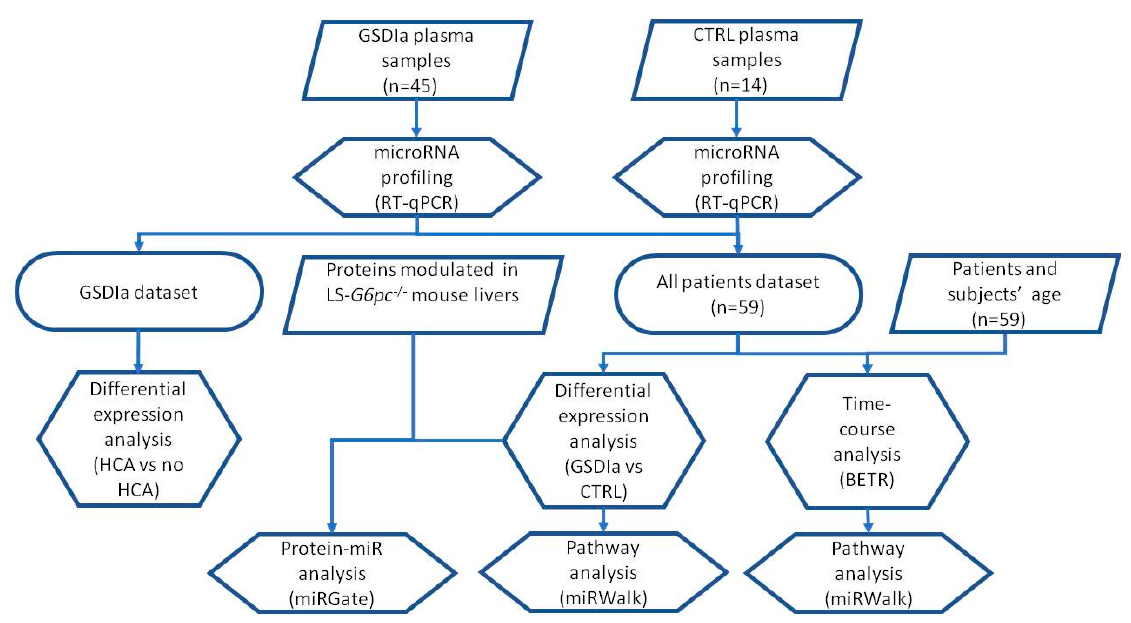
Figure 1. Schematic representation of the whole bioinformatic strategy used in the study. The Exo- miR representation profiles of plasma exosomes of 45 GSDIa patients and 14 CTRL subjects were measured via ViiA 7 RT-qPCR. Differential expression analysis assessed any significant modulation of the Exo-miRs between GSDIa patients and CTRL subjects or GSDIa patients characterized by the presence/absence of hepatic adenomas. The representation profile of GSDIa patients and CTRL subjects over three distinct age groups was compared using BETR method. Pathway analysis carried out on significantly modulated Exo-miRs identified the most significantly altered biological processes and pathways using the MirWalk tool. The potential regulatory activity of Exo-miRs in GSDIa patient liver was then evaluated using a set of proteins previously identified by our group to be modulated in LS- G6pc − / − mouse livers using the miRGate tool. Trapezoidal boxes around a text in the workflow indicate input data, hexagonal boxes indicate analyses, and smooth rectangular boxes indicate datasets. Table 1. Patient and healthy donors cohort characteristics.